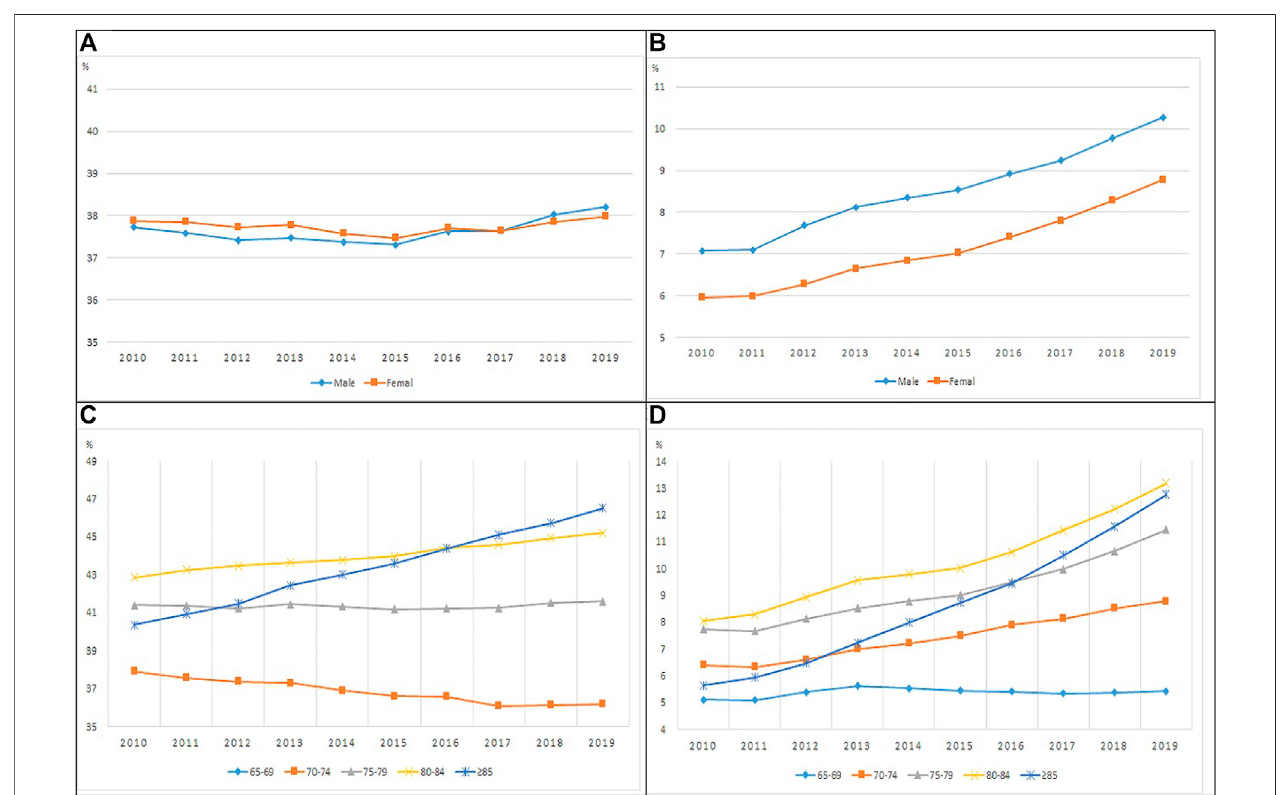
FIGURE 3 | The proportion of polypharmacy and hyper-polypharmacy among ≥ 180 days use elderly by sex and age group (A, C) : Polypharmacy, (B, D) : Hyper- polypharmacy).